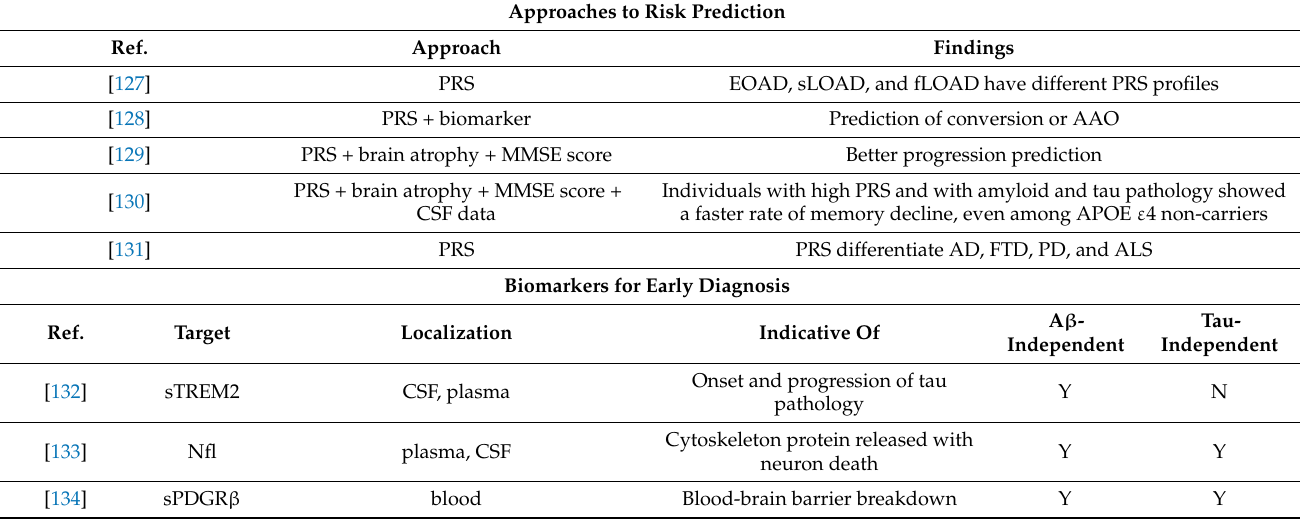
Table 1. Summary of selected recent studies of risk prediction, early diagnosis, and treatment.